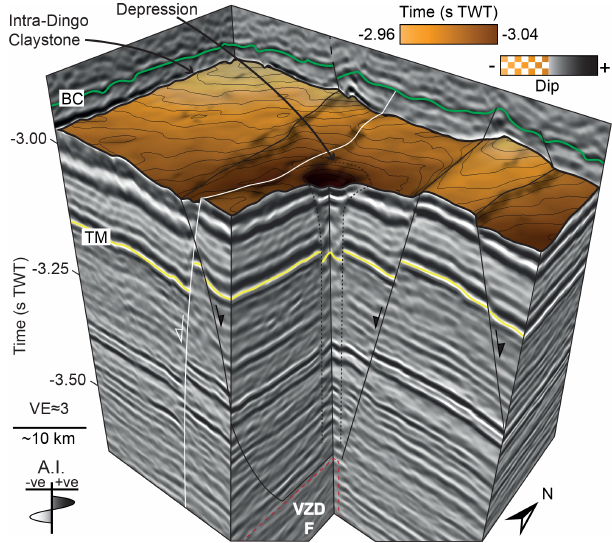
Figure 13. 3D view of the top of a sub-circular depression, devel- oped above VZD F, expressed on an Intra-Dingo Claystone hori- zon. The sub-circular depression is underlain by a vertical pipe-like structure, which extends down to VZD F and contains stratigraphic reflections that are offset downwards relative to their regional